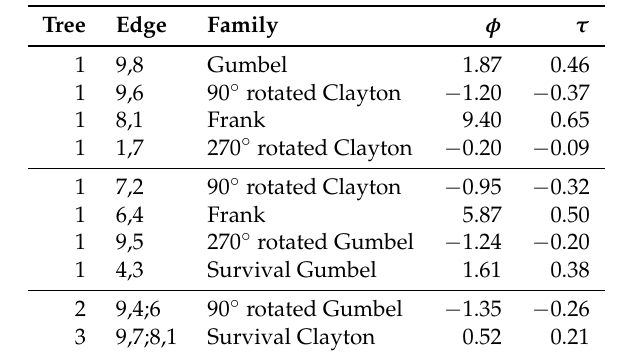
Table 5. Specification of vine structure.